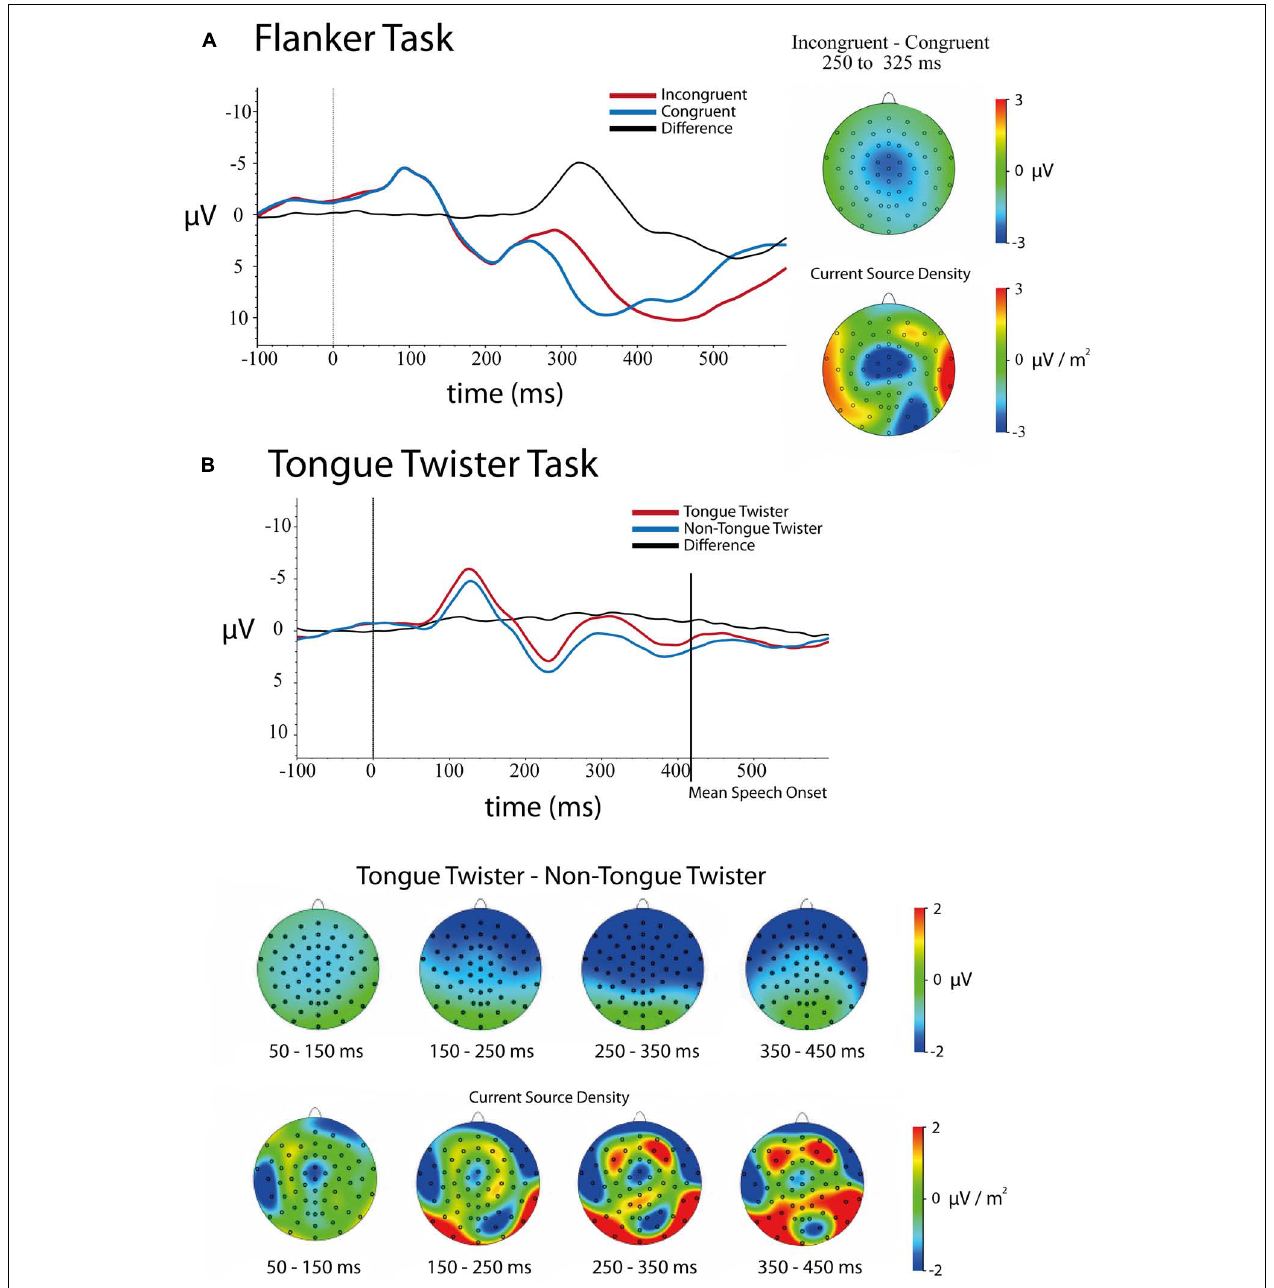
FIGURE 2 | Stimulus-locked ERPs and scalp topographies of differences for both tasks. Trials were baseline-corrected − 100 ms before stimulus onset. (A) Flanker task – congruent and incongruent trials ERPs at electrode FCz as well as scalp topographies of the mean amplitude (upper)and current